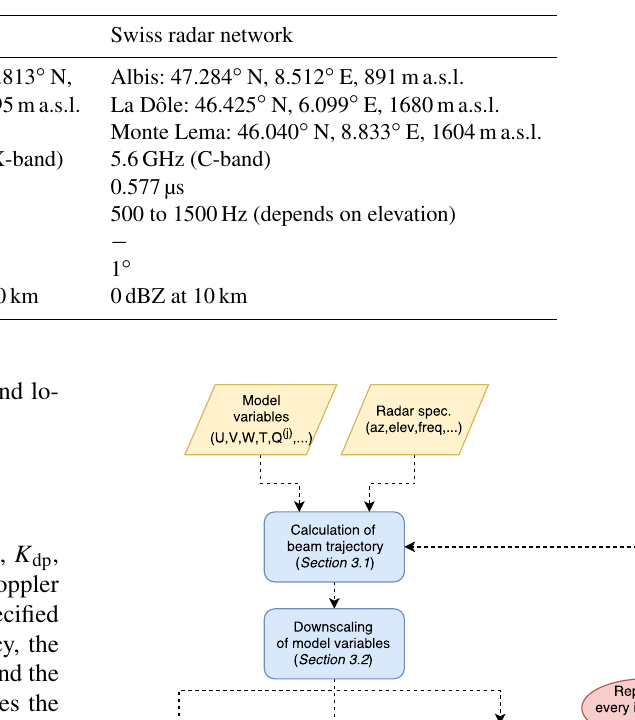
Table 2. Specifications of the ground radars used in the evaluation of the radar operator.